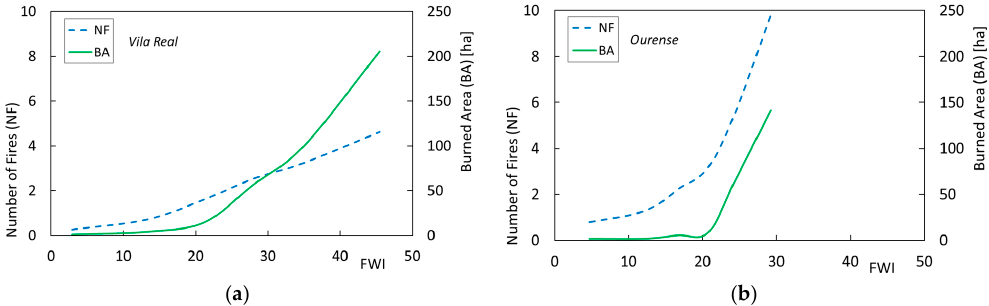
Figure A3. Average number of daily fires (NF) and burned area (BA) as a function of FWI for: ( a ) the Portuguese District of Vila Real and ( b ) the Spanish Province of Ourense.